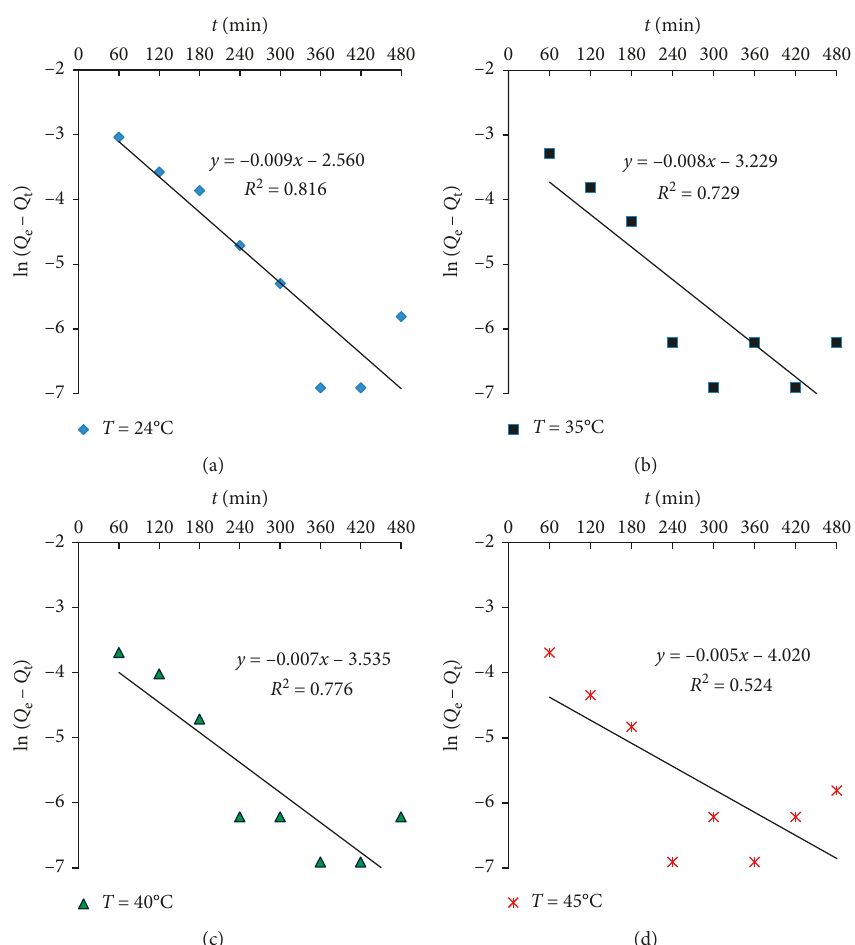
� 25ml, and phosphorus int